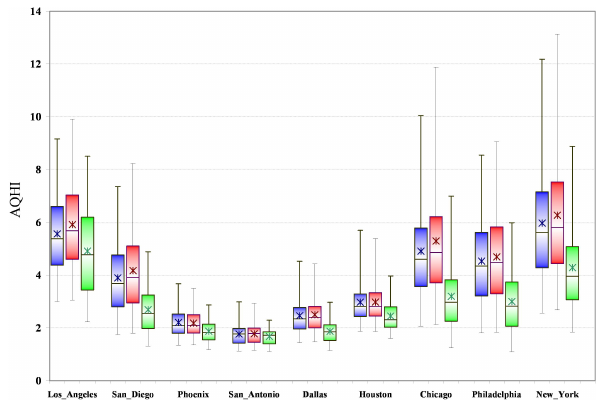
Fig. 13. As in Fig. 11, large American cities. Note the vertical scale change relative to Figs. 11,